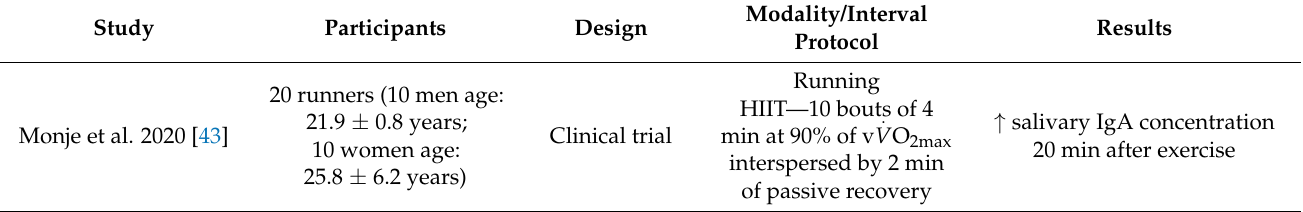
Table 1. Summarize of studies investigating the acute effects of interval training on immune